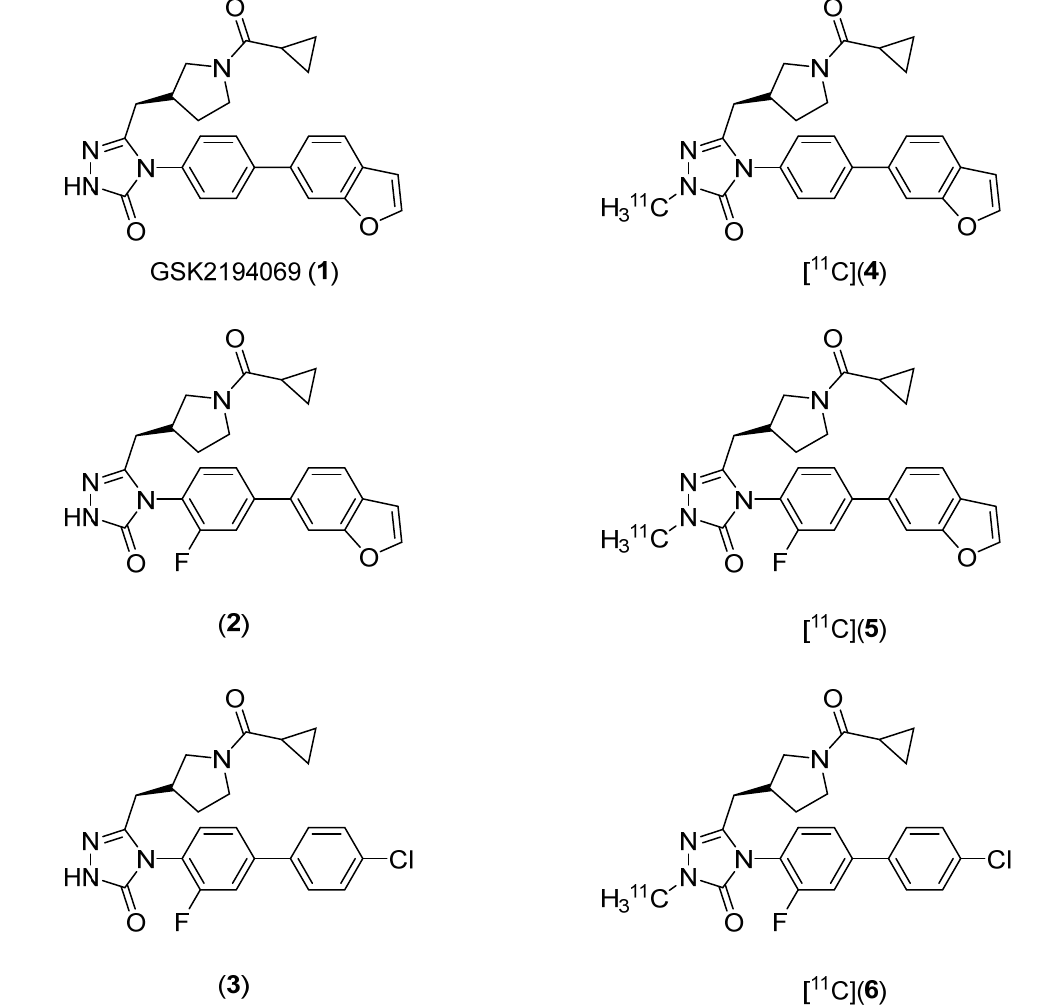
Figure 1. Target compounds. Fluorine-containing compounds 2 and 3 , and their derivatives [ 11 C] 5 and [ 11 C] 6 , were selected to allow the possibility of 18 F-fluorination as an alternative labeling strat- egy.